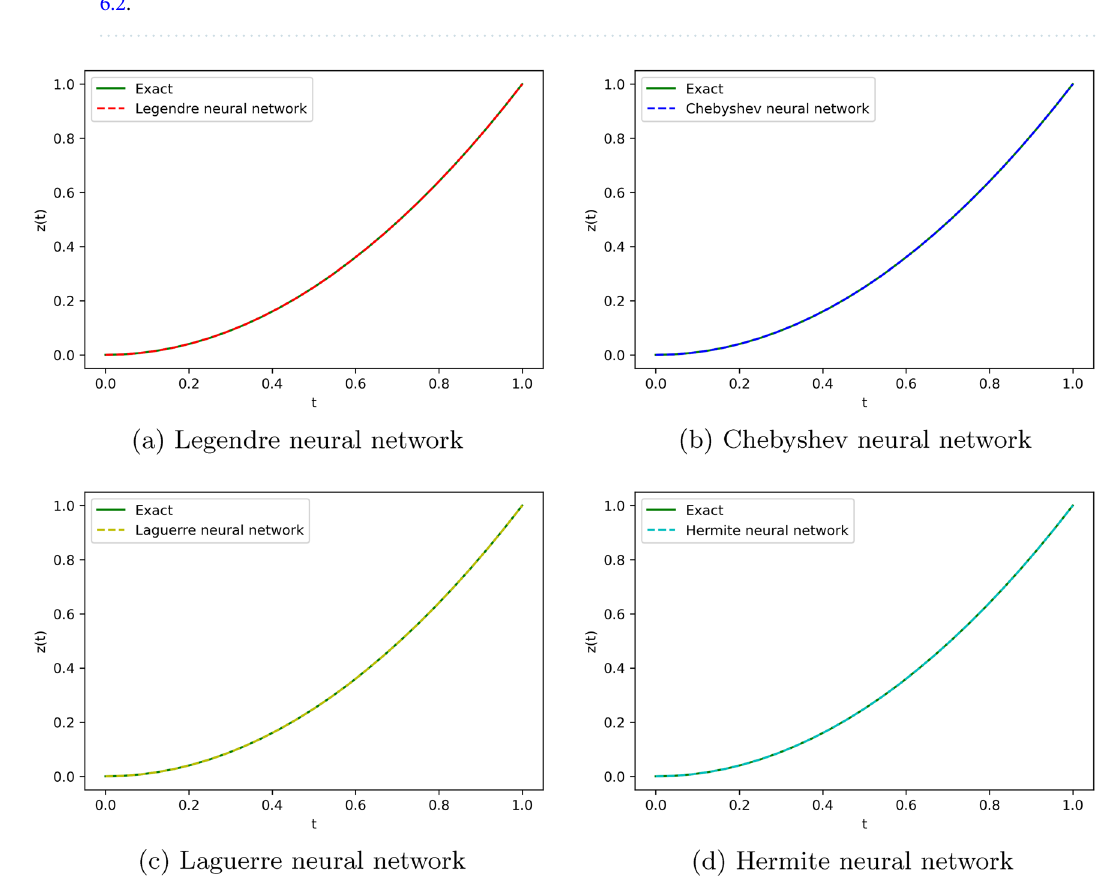
Figure 5. Comparison of the exact solution with the obtained approximate solutions of Example 6.2.